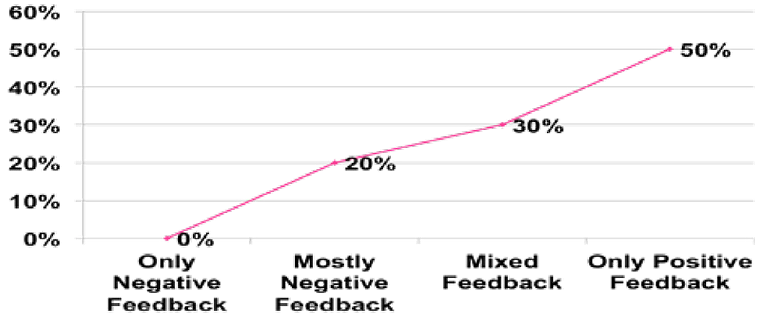
Figure 2. General impressions of the teleconsultation